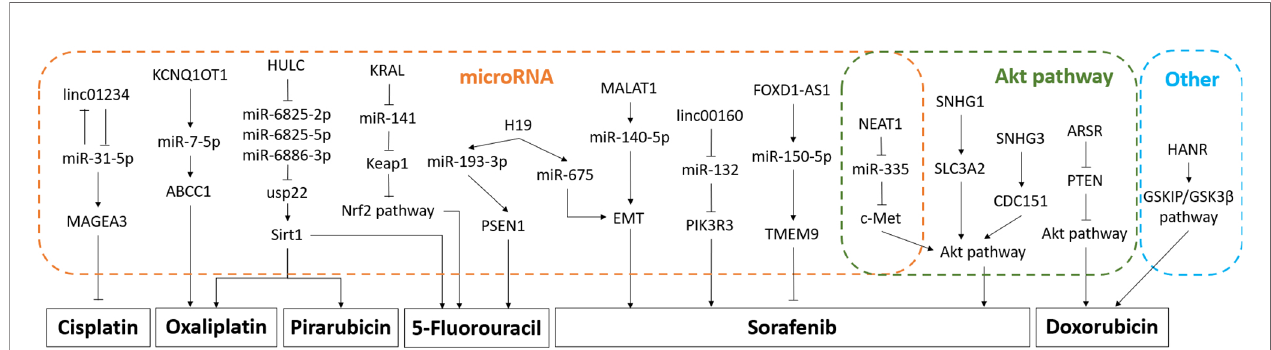
FIGURE 1 | Diagram of the mechanism of lncRNA mediating chemotherapy resistance. Part of the mechanism is related to microRNAs, and part is related to Akt pathway. The promotion arrow in the panel refers to the promotion of drug resistance to the corresponding chemotherapeutic drug, and the inhibition arrow refers to the increase of the sensitivity to the chemotherapy